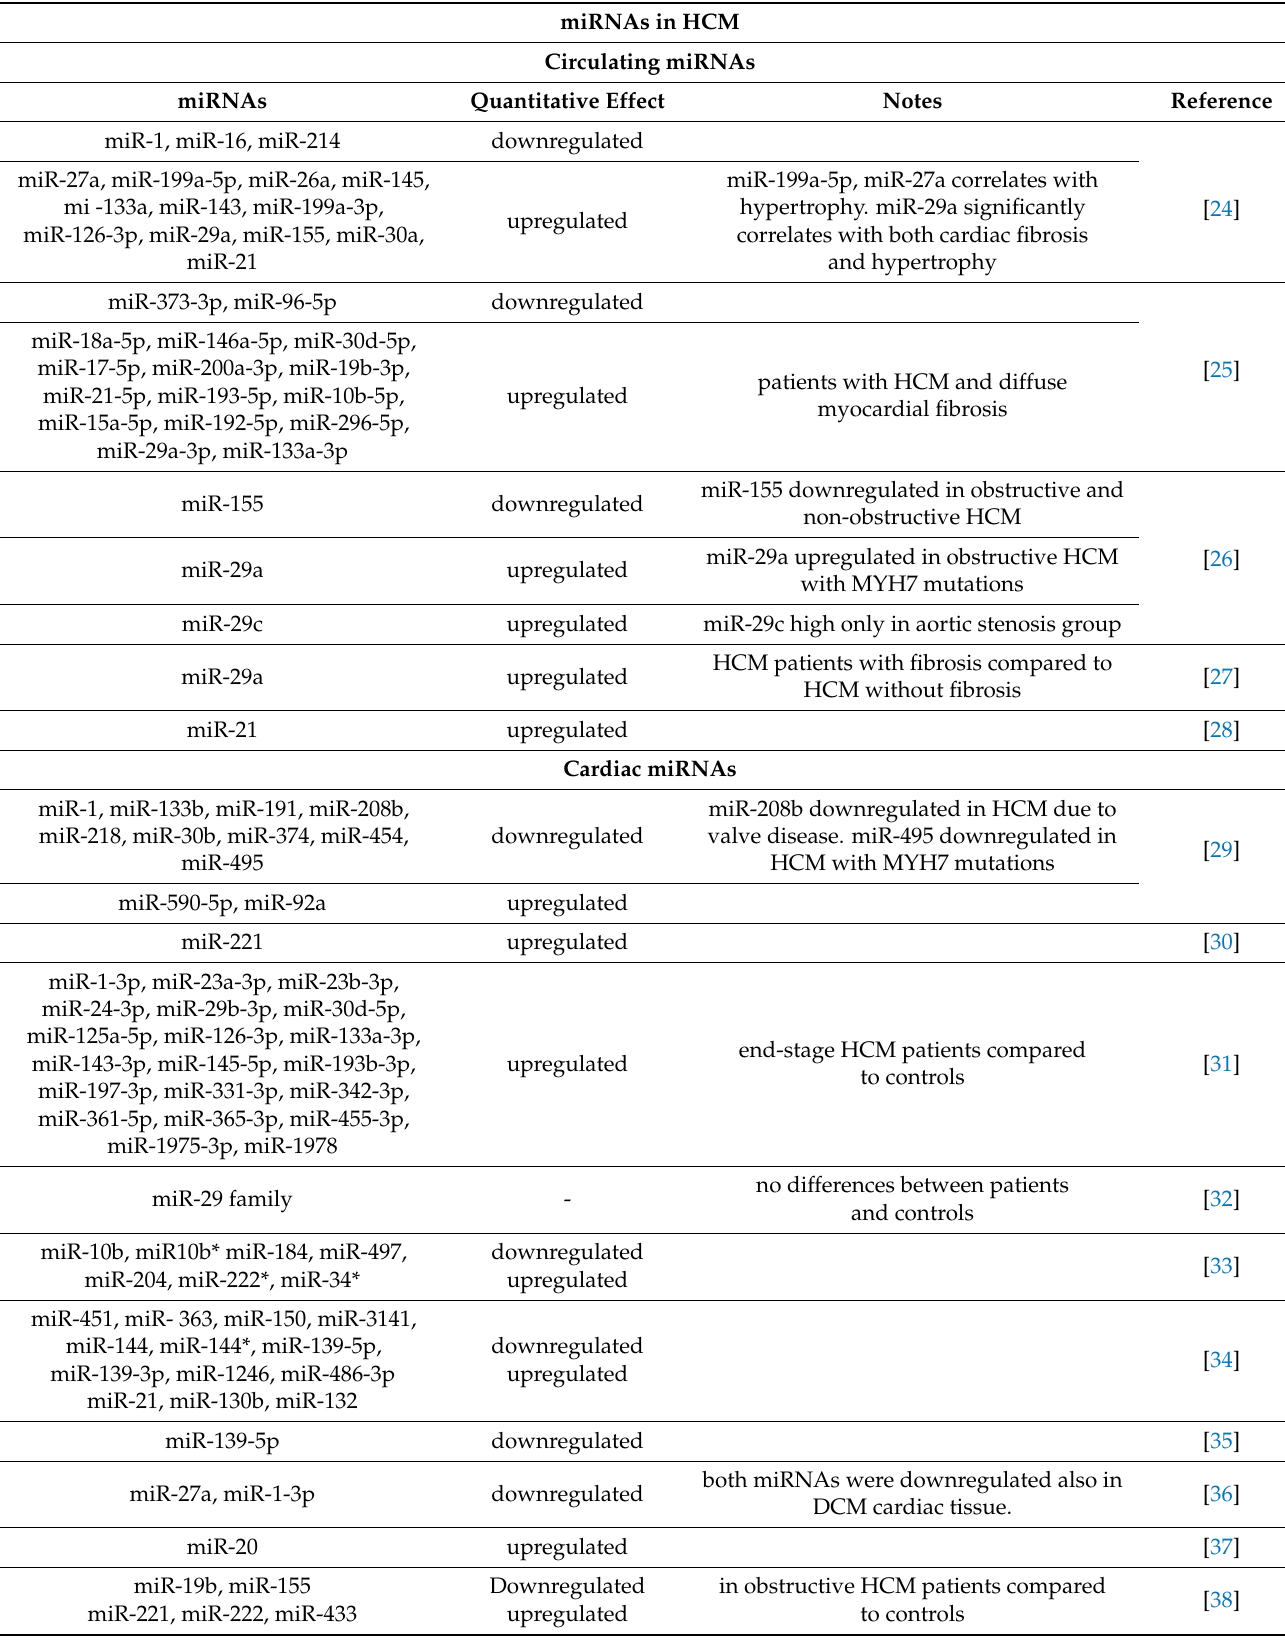
Table 1. Summary of miRNAs involved in human